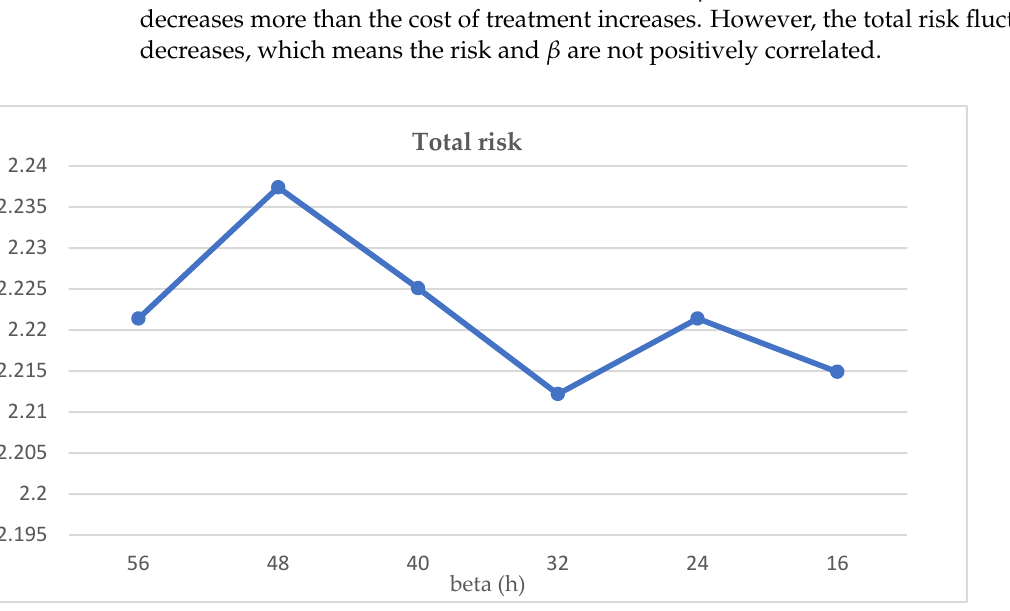
Figure 11. Sensitivity analysis of total risk regarding the changes in time limit.